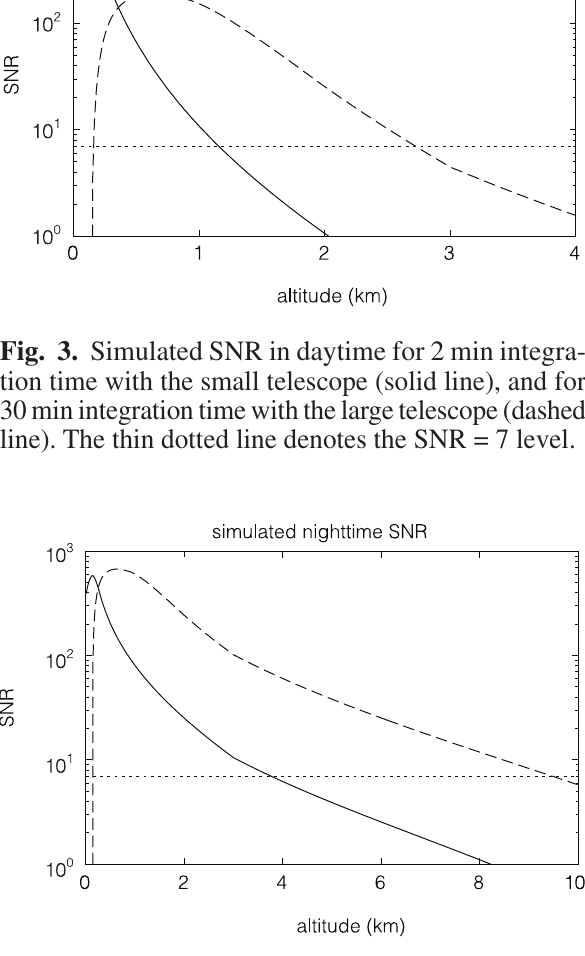
Fig. 4. Simulated SNR in nighttime (no background) for 2 min integration time with the small telescope (solid line), and for 30 min integration time with the large telescope (dashed line). The thin dotted line denotes the SNR = 7